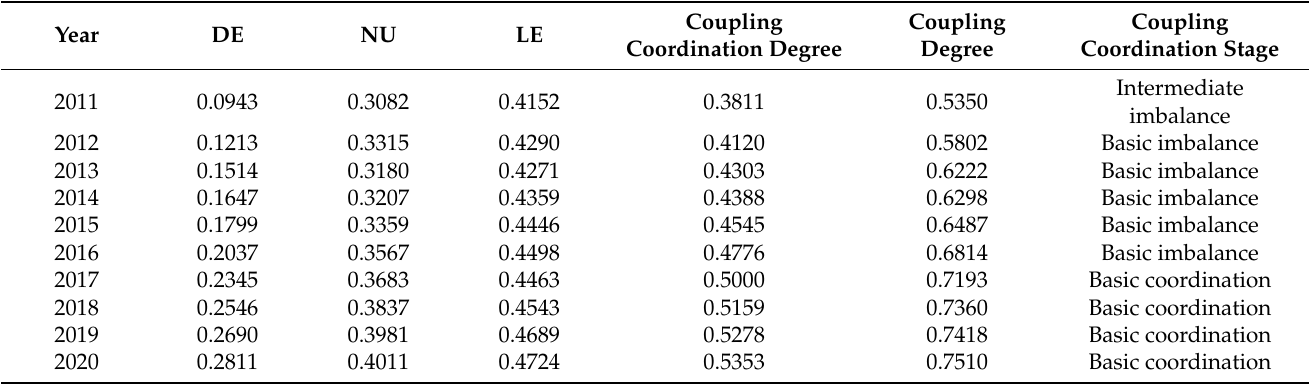
Table 3. Development indexes and coupling coordination degree of DE–NU–LE in the Yangtze River